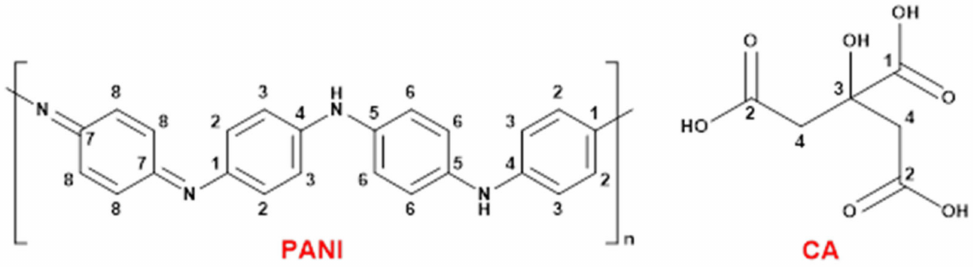
Figure 3. Molecular structures of PANI and CA and a carbon numbering